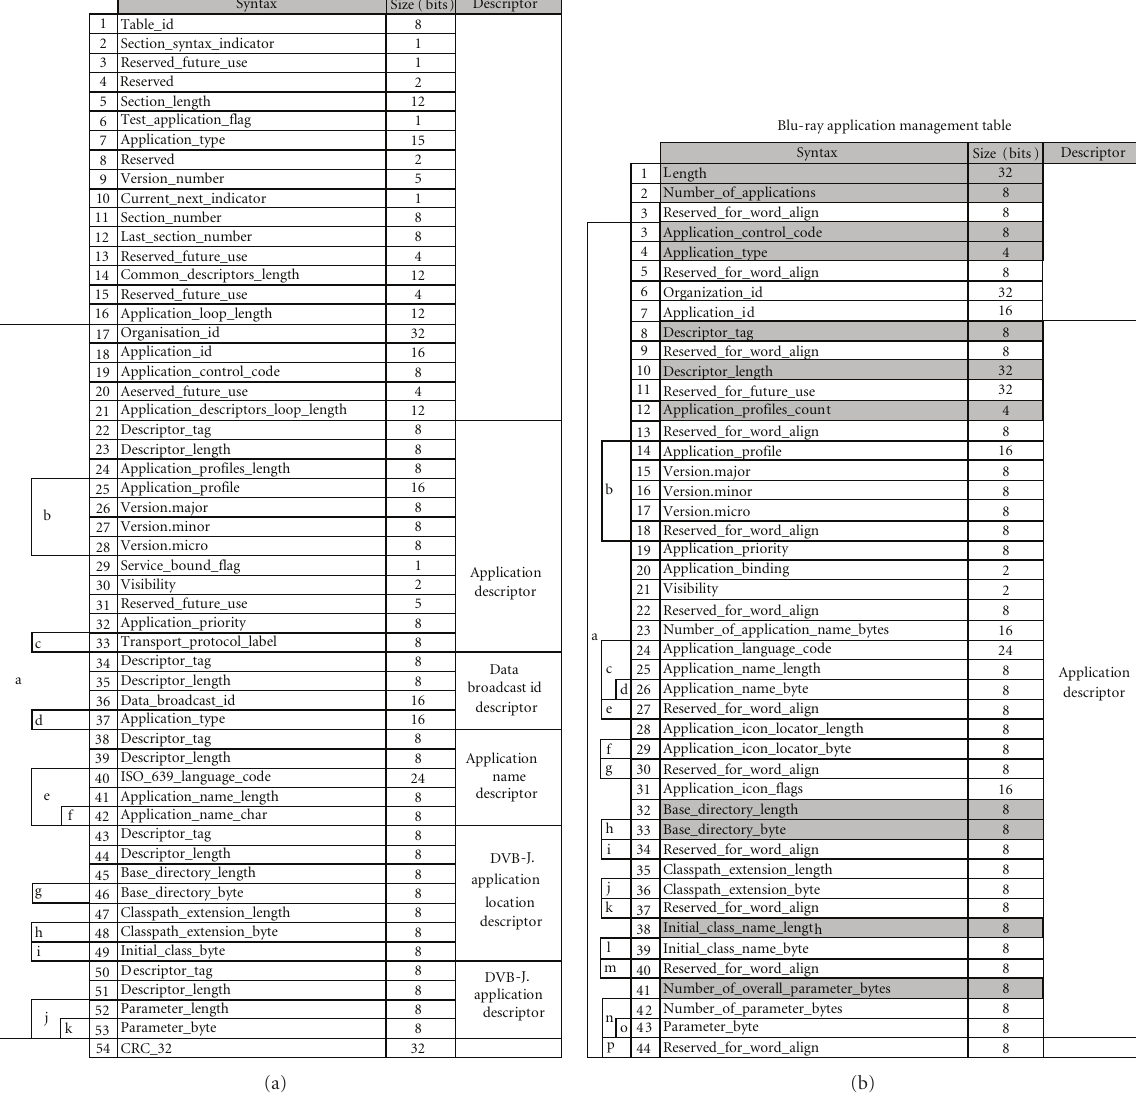
from the equivalent AIT fields (fields 32, 29, and 30, resp., in Figure 14(a)). The values of field 23 and field in the block labelled as c in Figure 14(b) are also directly copied from the AIT equivalent fields (field 39 and block e in Figure